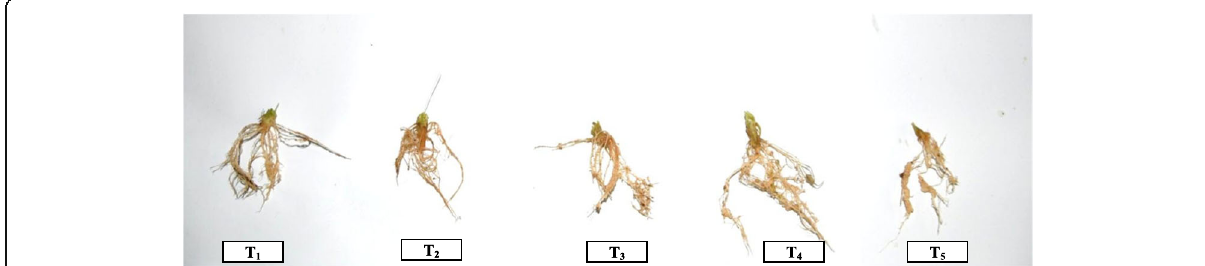
Fig. 1 Effect of different levels of Meloidogyne incognita in presence of Fictor composticola on gall formation of Meloidogyne incognita in cucumber (T1= Uninoculated check, T2= 250 J 2 , T3= 500 J 2 , T4= 1000 J 2 and T5= 2000 J 2 per